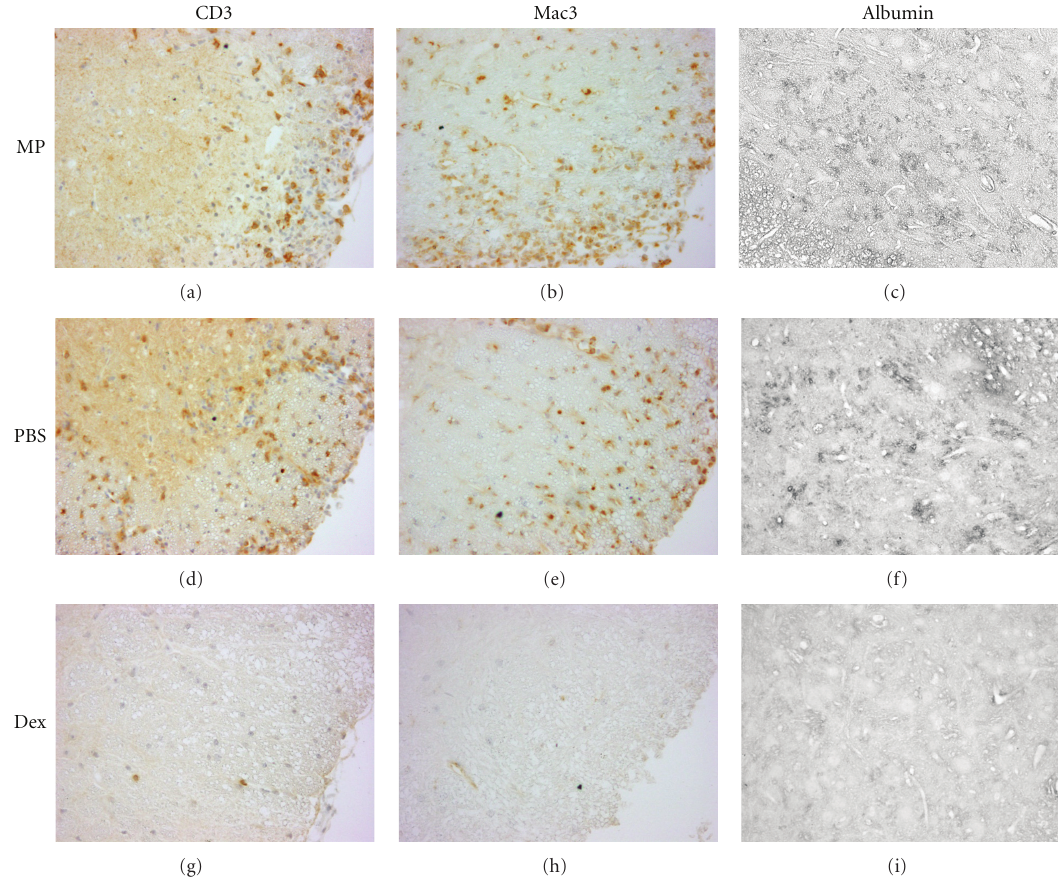
Figure 2: Immunohistochemical analysis of EAE following preventive GC administration. Immunohistochemical stainings are depicted for infiltrating T cells (left), macrophages/monocytes (middle), and albumin as marker of blood-brain-barrier integrity (right) in the lumbar spinal cord of one representative mouse of each treatment group (top: 100 mg/kg MP, middle: control, bottom: 100 mg/kg Dex) sacrificed on day 12. Magnification =